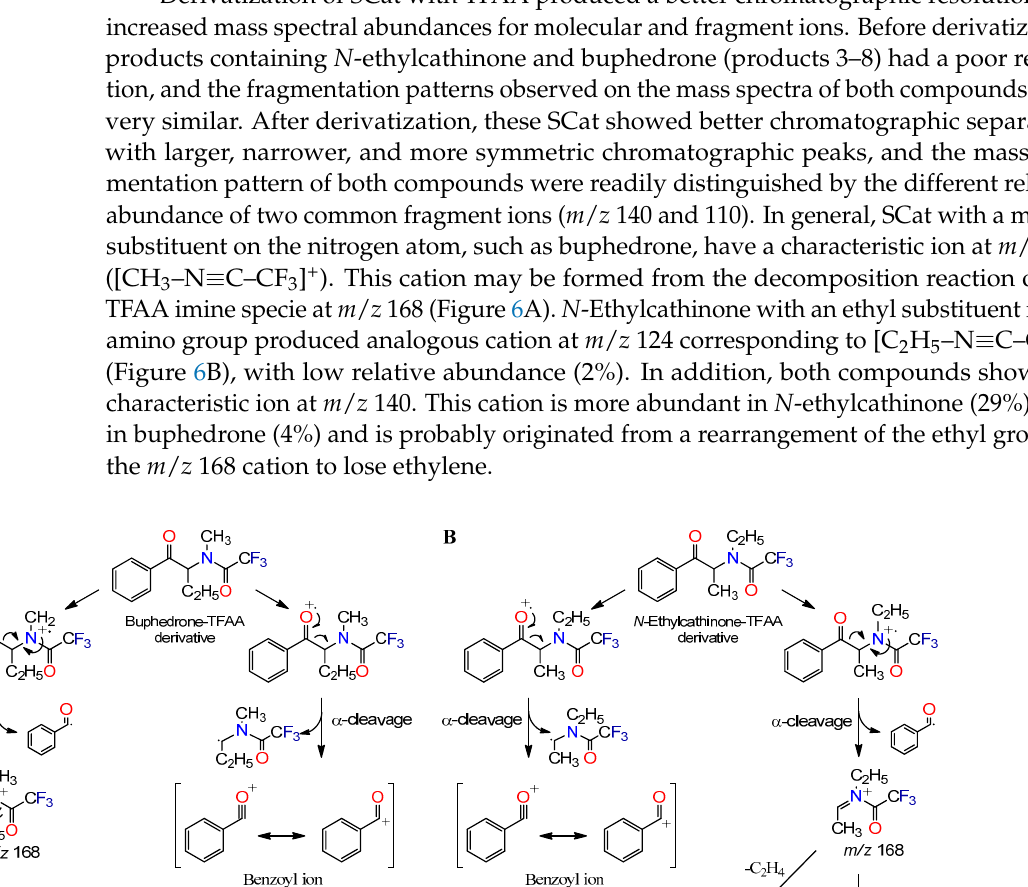
Figure 5. EI mass spectra of ( A ) buphedrone ( B ) N -ethylcathinone ( C ) methedrone ( D ) methylone ( E ) 3-FMC and ( F ) pentedrone after derivatization with TFAA.